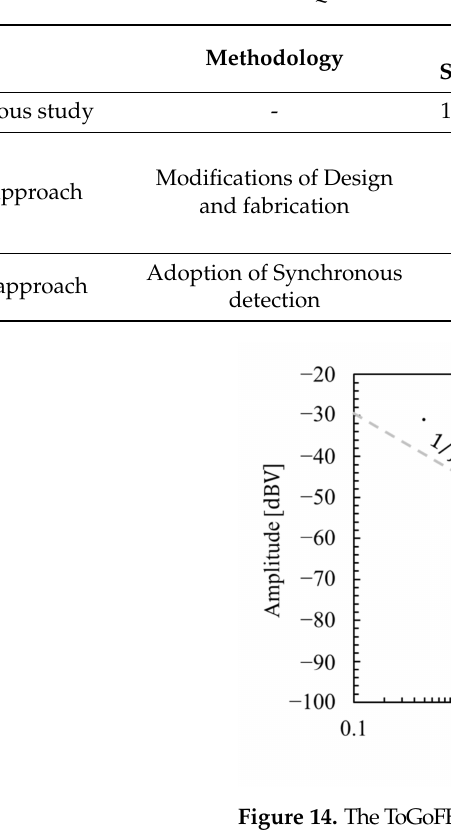
Figure 13. The deviations of the line profiles in ToGoFET images: ( a ) The differences when applying input voltages of 40 and 1000 mV pp . ( b ) The deviations by the input voltage. Table 1. Quantitative comparison with the previous research results.